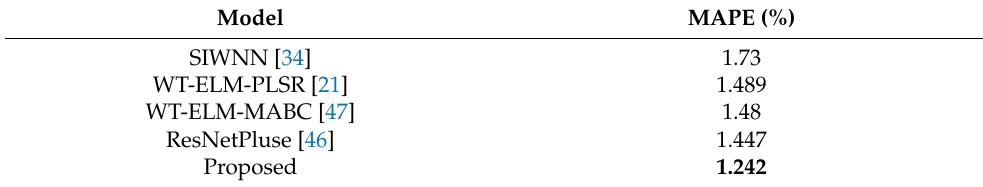
Table 7. MAPEs of the proposed model with the ISO-NE dataset in Test Case